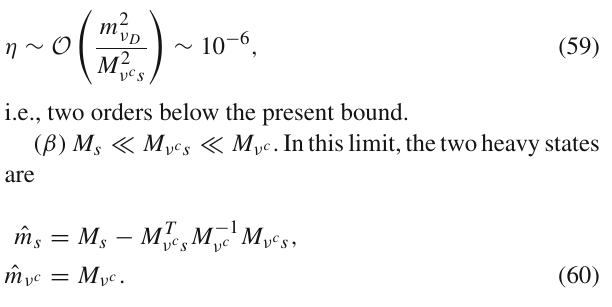
is well known, right-handed neutrinos can decay to a lepton and a Higgs field, producing this way lepton asymmetry. The relevant Yukawa couplings